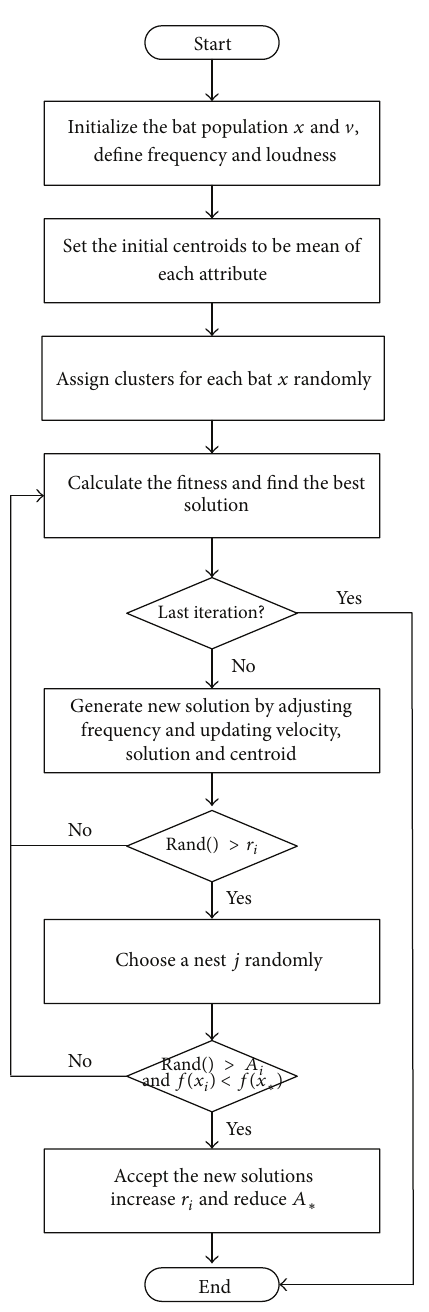
Figure 3: Workflow of C-Bat algorithm.